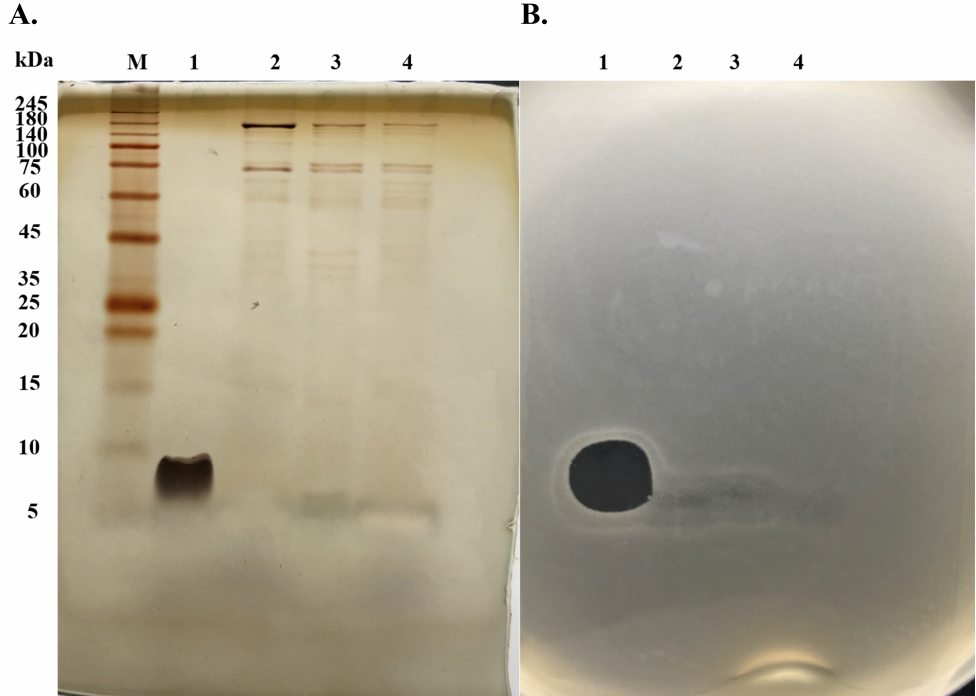
Figure 4. ( A ) Silver-stained SDS-PAGE gel that separated the fractions from each purification step. Lane M, protein marker; Lane 1, P1 from RPC; Lane 2, fraction from CIEX; Lane 3, fraction from ammonium sulfate precipitation; Lane 4, cell-free supernatant. ( B ) Agar overlay assay by which the corresponding gel was overlaid by soft agar containing MRSA isolate 2468. The plate was incubated at 37 °C for 24 h. CIEX, cation exchange chromatography; RPC, reversed-phase chromatography.